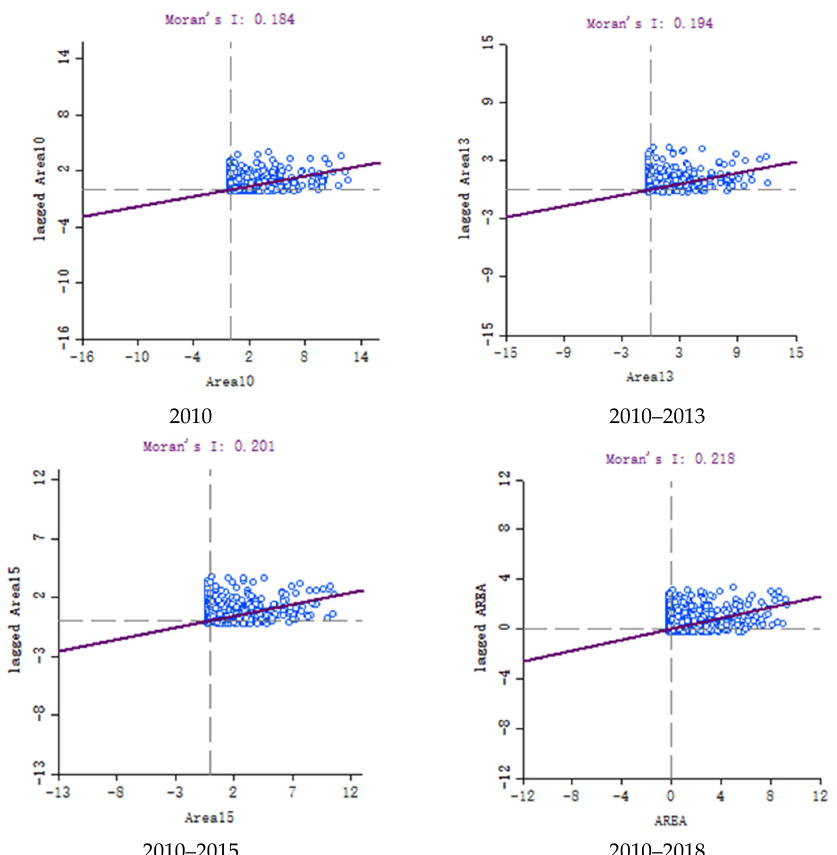
Figure 8. Annual cumulative statistically Moran’s I of urban village redevelopment, 2010–2018.